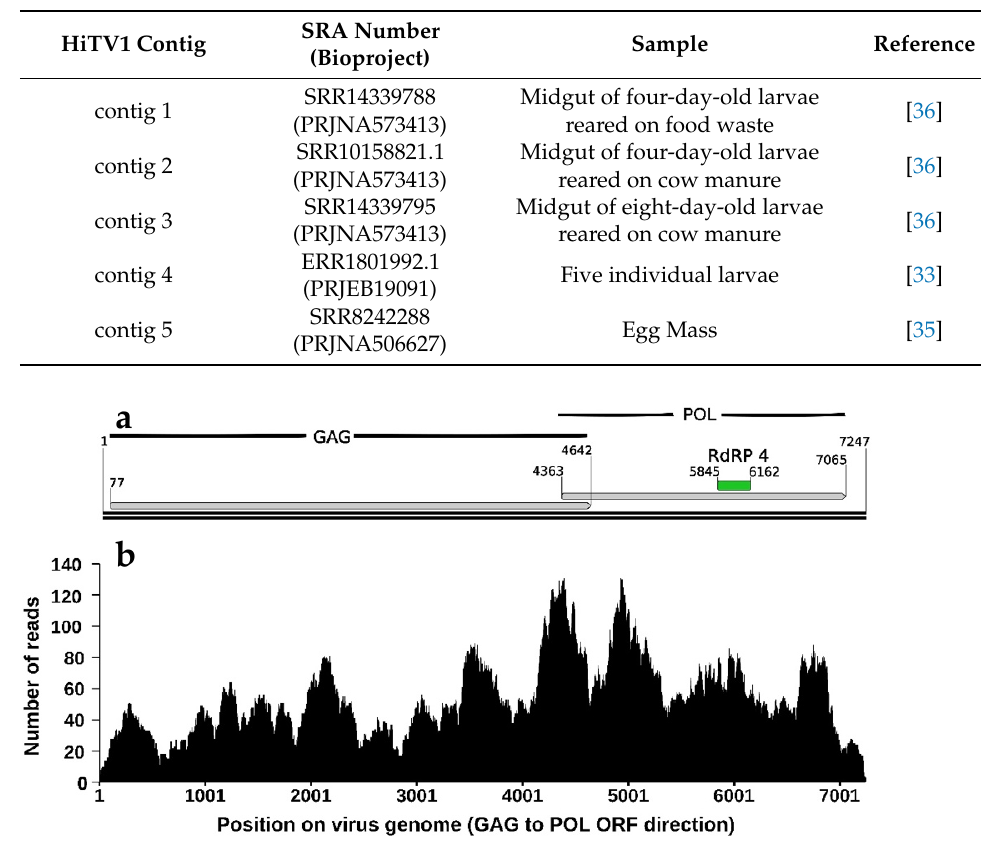
Table 2. RNAseq datasets containing HiTV1 contigs longer than 5 kb.